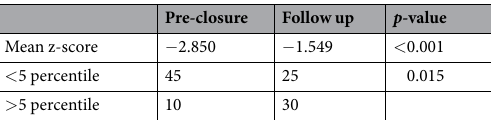
Table 7. Growth difference after enterostomy